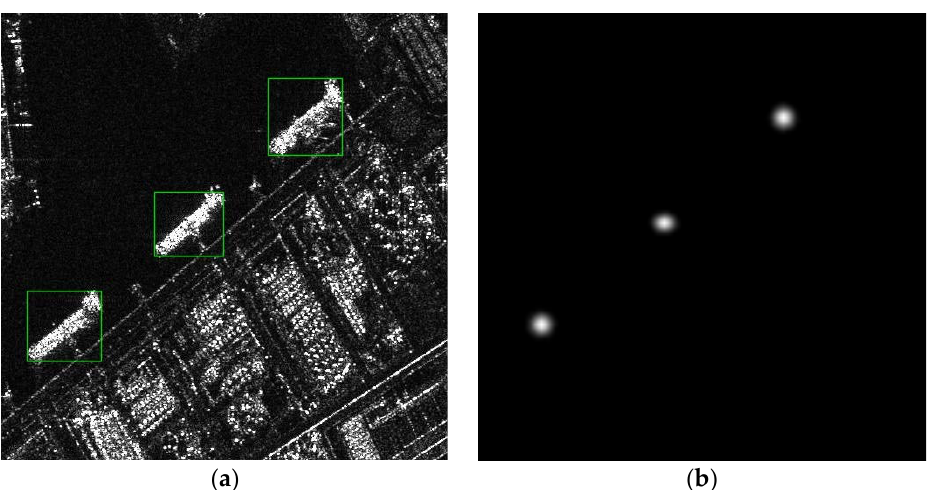
Figure 2. Training image and its corresponding ground truth of localization branch. ( a ) A typical training image. ( b ) The corresponding ground truth of localization branch in original image scale.